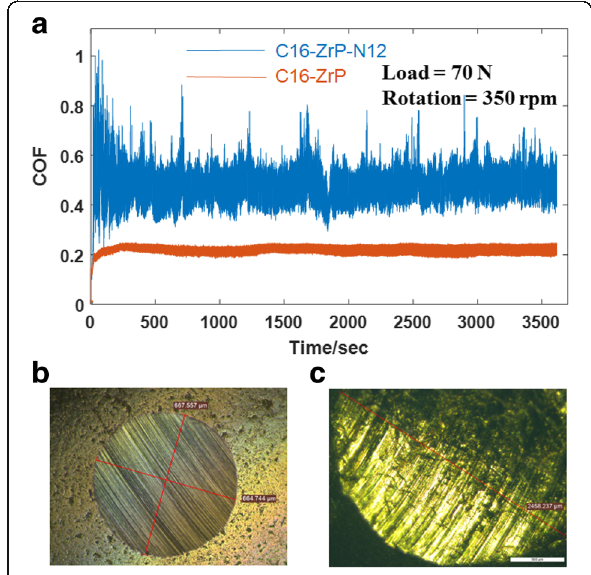
Fig. 4 a Friction coefficients of surface-modified ZrP nanoplatelets without and with intercalations (C16-ZrP and C16-ZrP-N12) in mineral oils under a load of 80 N and rotation speed of 350 rpm. Optical microscopic images of the wear scar images for b C16-ZrP and c C16-ZrP-N12 in mineral oils after